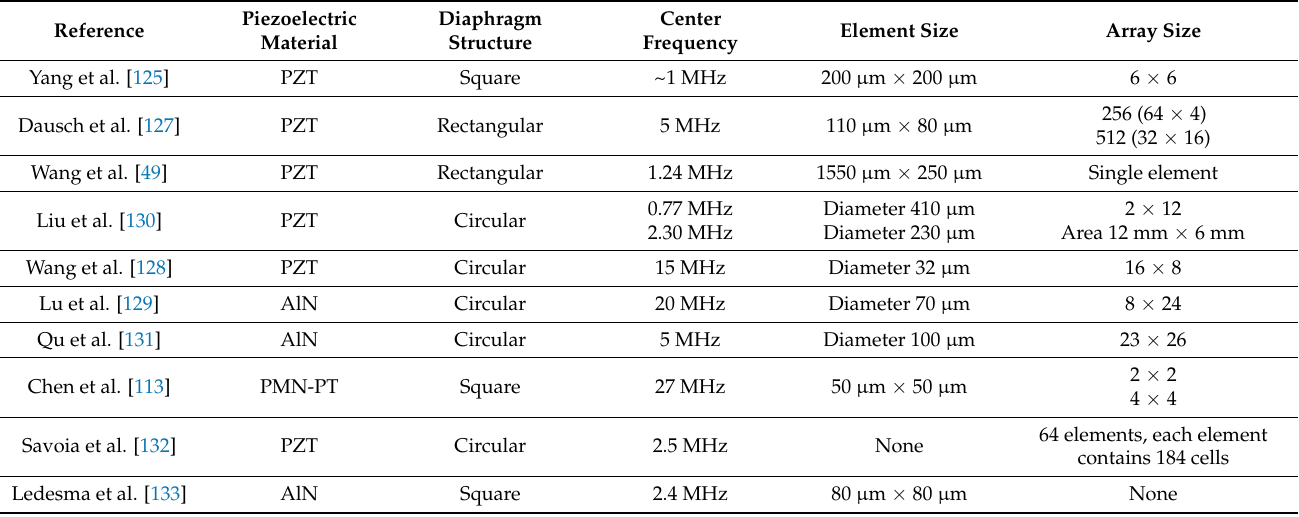
Table 4. Summary of studies of PMUTs for ultrasound imaging